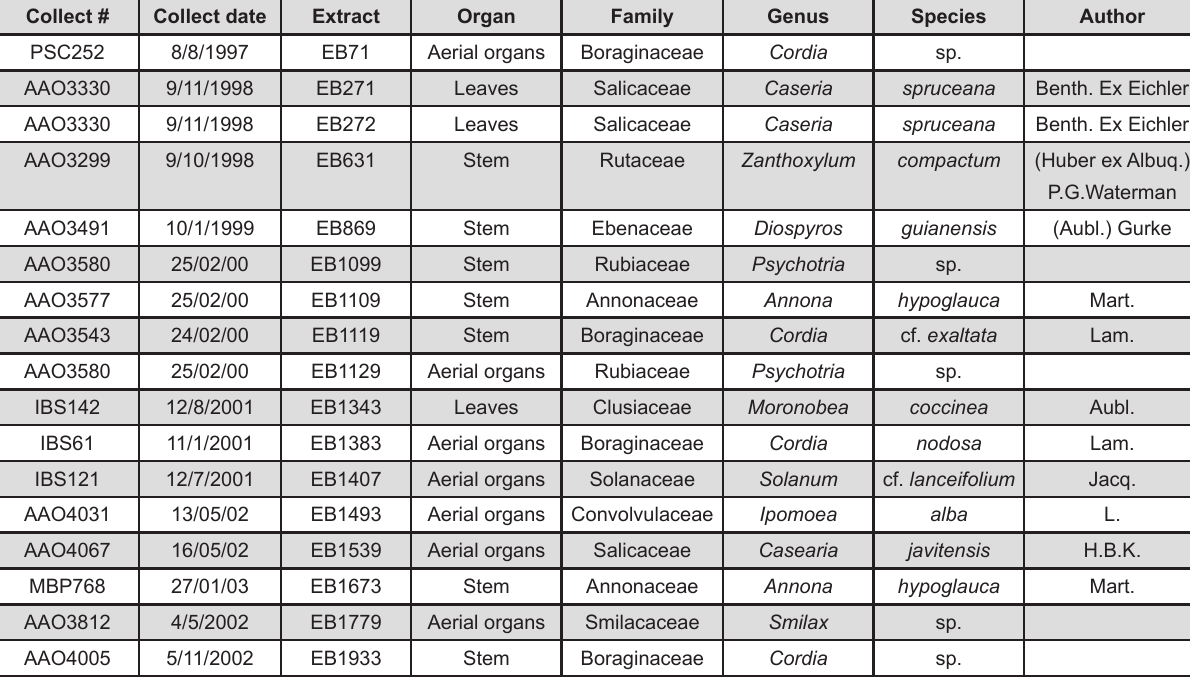
Figure 1- Botanical data related to the plants that originated active